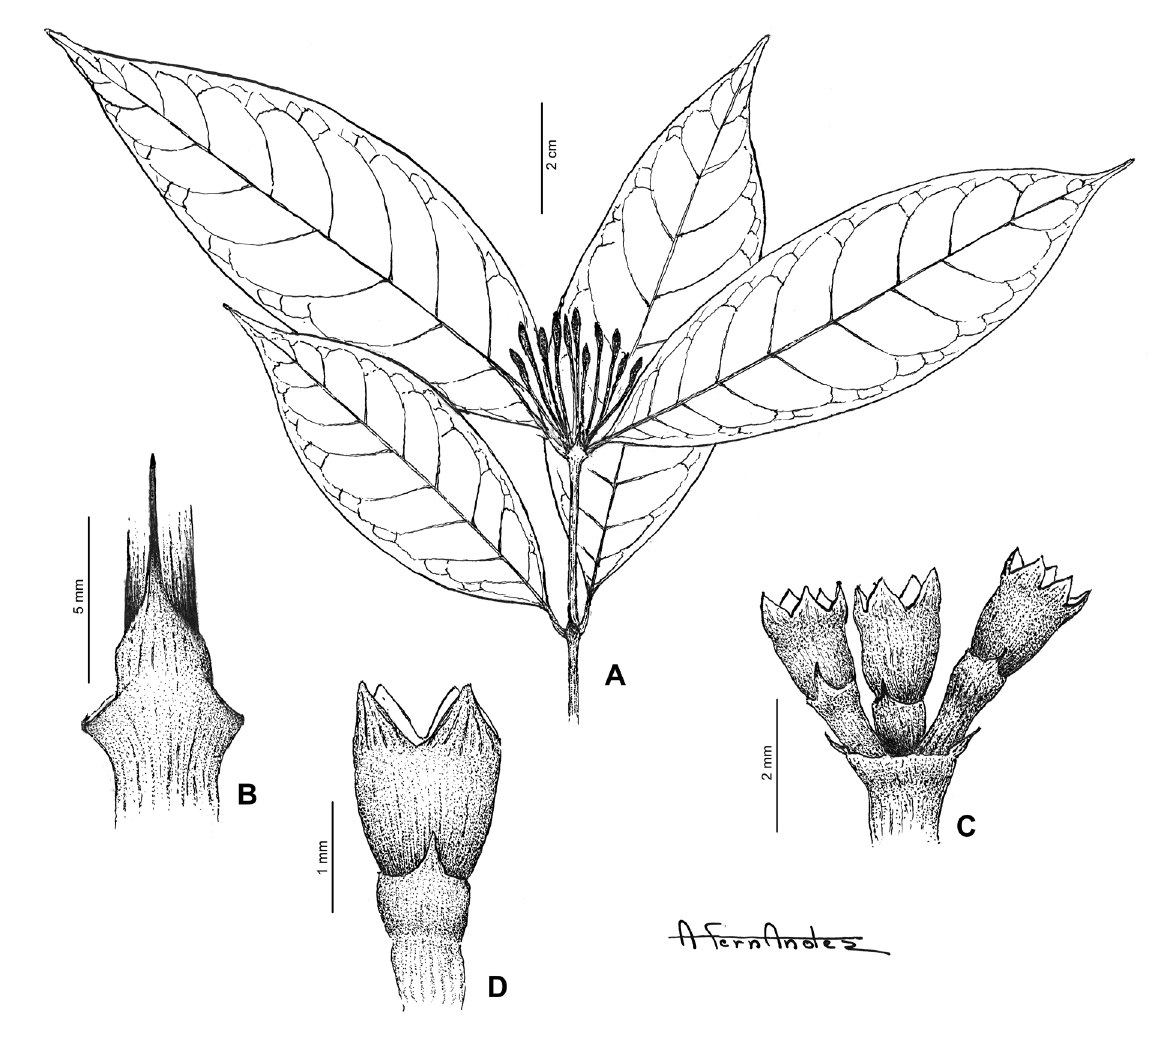
Figure 1 – Ixora kalehensis : A, flowering branch; B, stipule; C, triad (corollas removed); D, bracteole, ovary and calyx. From Troupin 4662 (BR). Drawn by A.